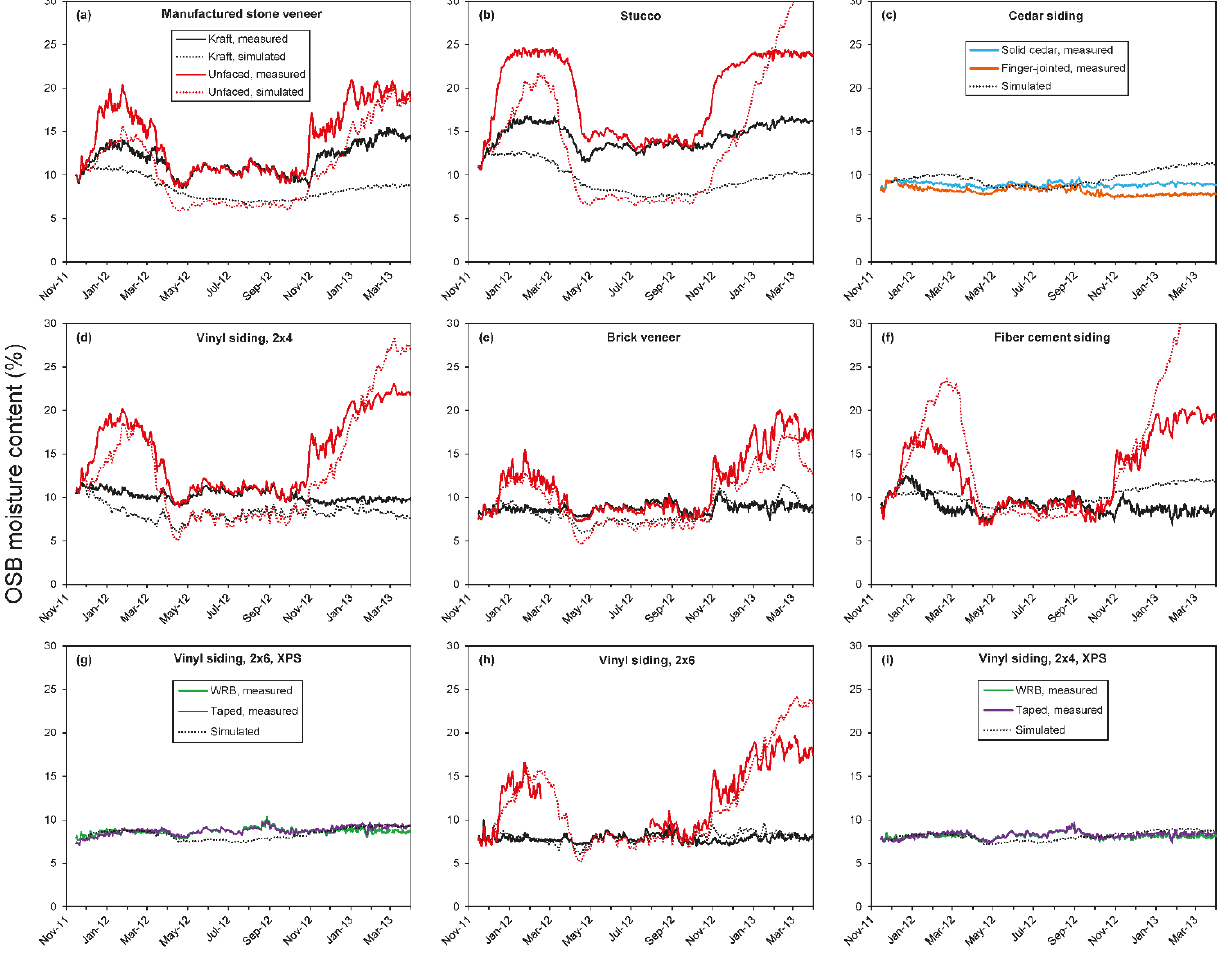
Figure 12. Measured and simulated OSB moisture content in south-facing